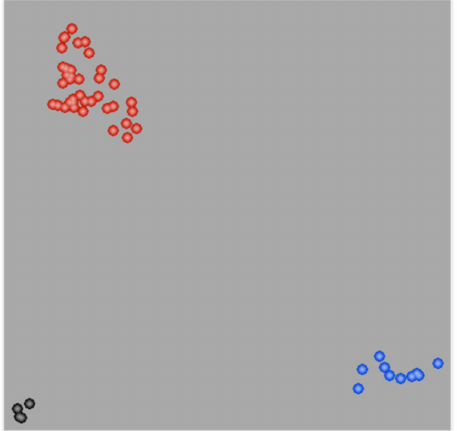
Figure 3. KASP genotyping results with the marker JHI-Hv50k-2016-156842. The red group denotes the G allele, and the blue group denotes the A